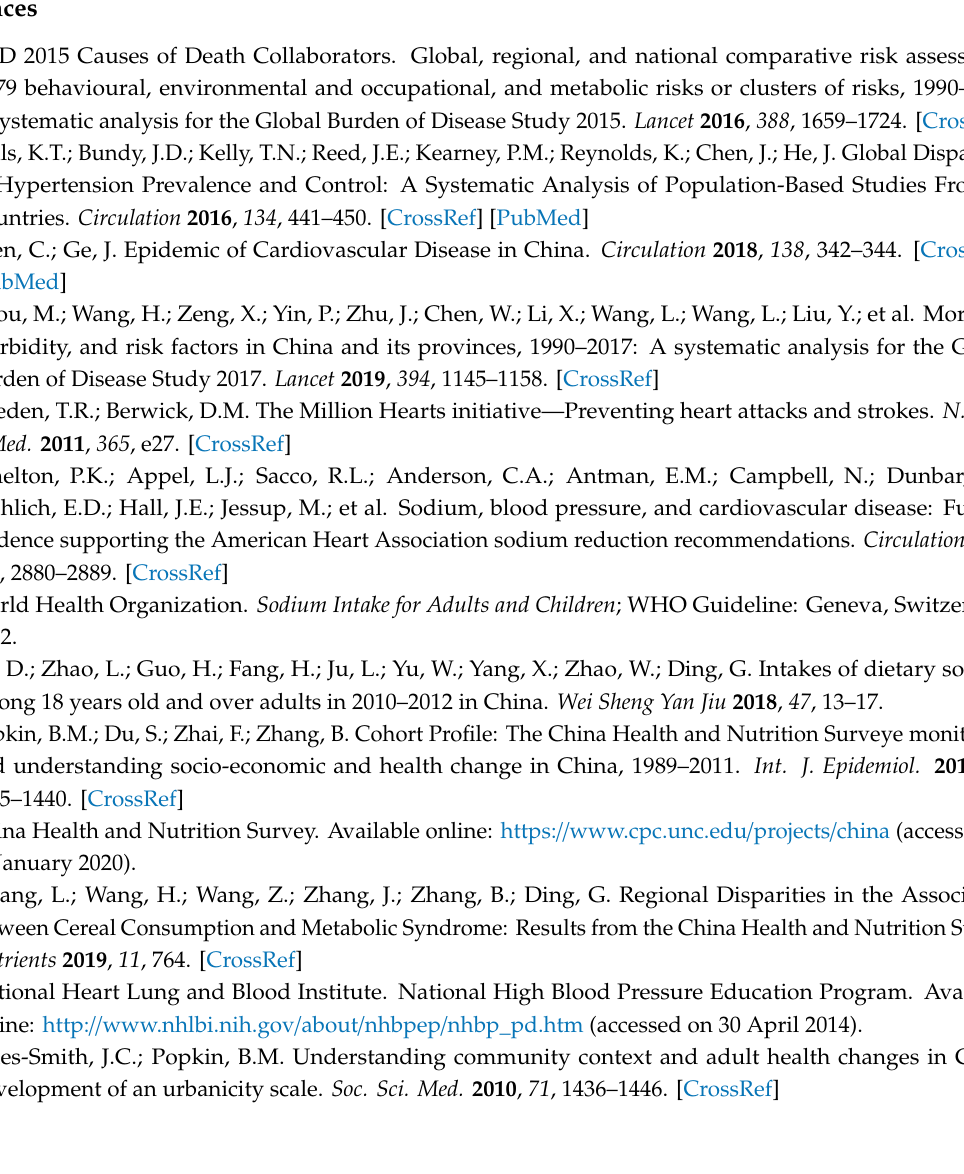
Table S1: Baseline characteristics of participants according to area quartiles of dietary potassium